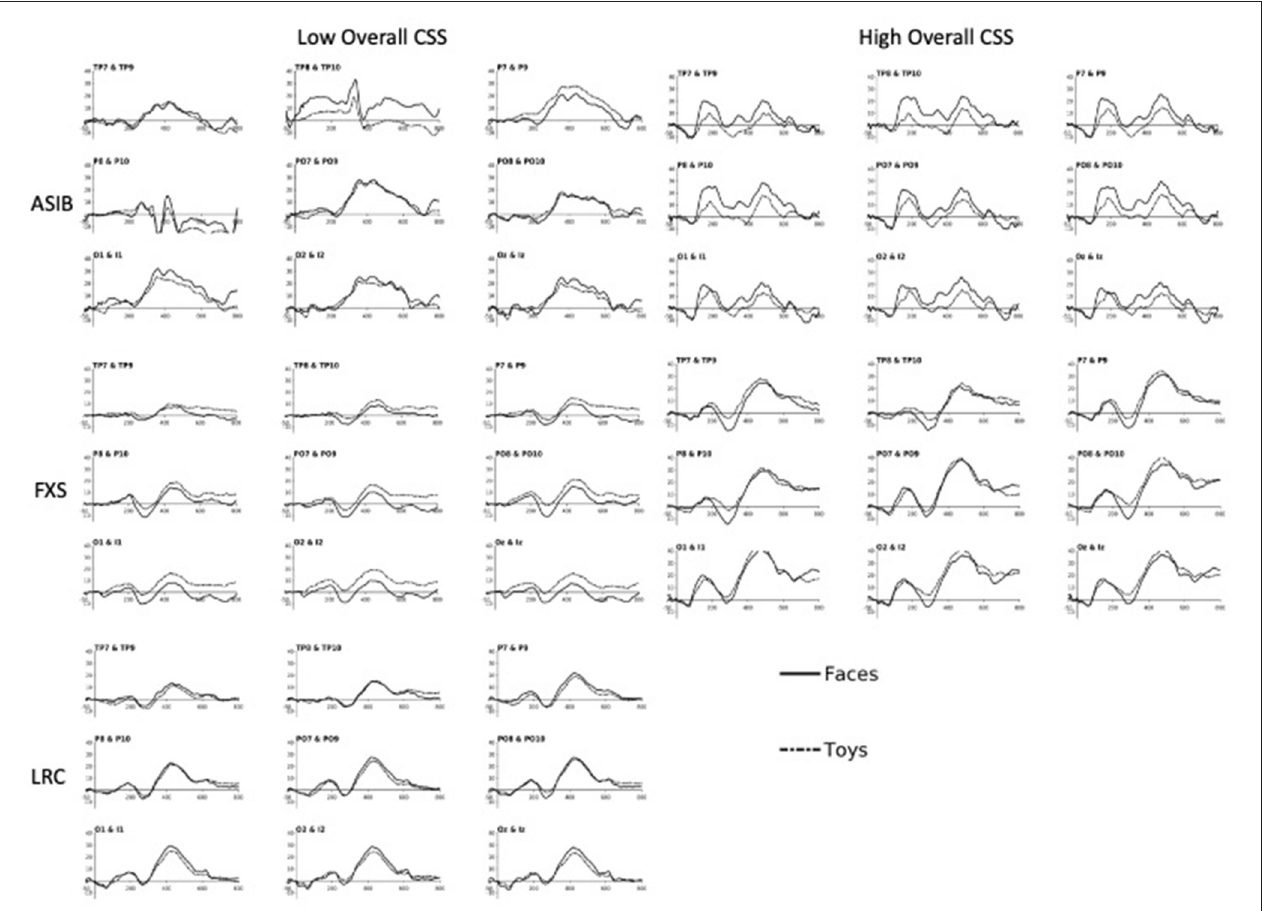
FIGURE 2 | The N290 and P400 responses to faces and toys across subgroups of ASIB, FXS, and LRC participants. Plots labeled “Low Overall CSS” include participants with an Overall CSS of three or less on the ADOS-2. “High Overall CSS” includes participants with an Overall CSS of seven or higher on the ADOS-2. Participants scoring in the mid-range (i.e., scores of four to six) are not represented in these plots. There were not enough LRC participants to create “High Overall CSS” plots. Plots are presented at relevant “virtual 10-10 electrode” clusters, including Temporal Parietal (TP), Parietal (P), Parietal Occipital (PO), Occipital (O), and Inion (I) clusters [see ( 13, 36) for more details on calculation of 10-10 virtual